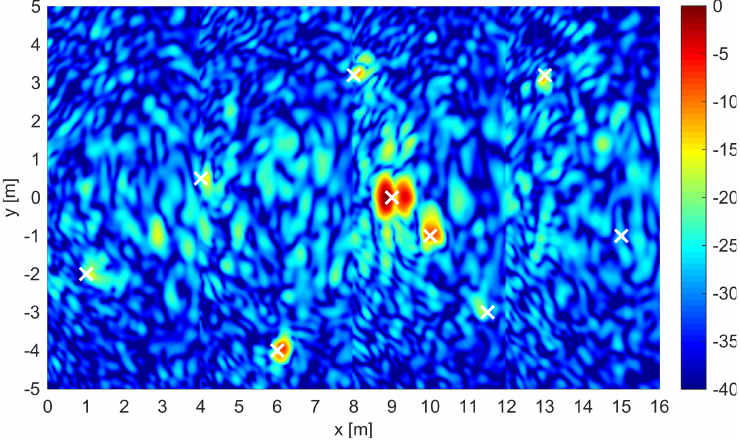
Figure 5. Image obtained by integrating six apertures for the same scene as in Figure